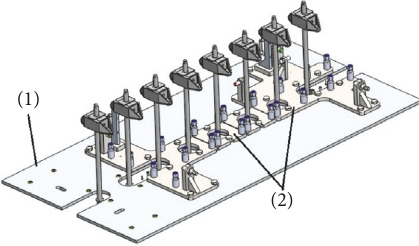
Figure 2: Structure of modular fixture. (1) Quick change position- ing plate and (2) modular unit.